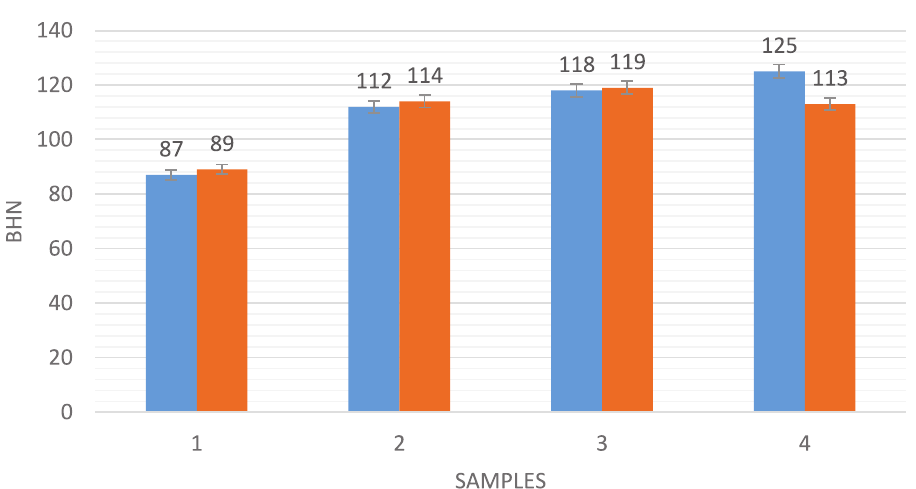
Fig. 13. Comparative chart for the